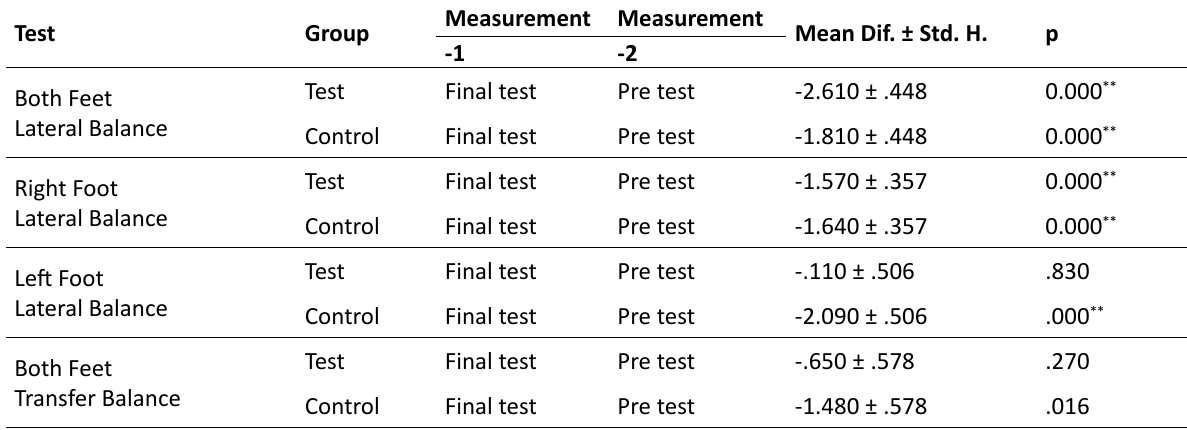
Table 9. Simple effect test results according to balance test values